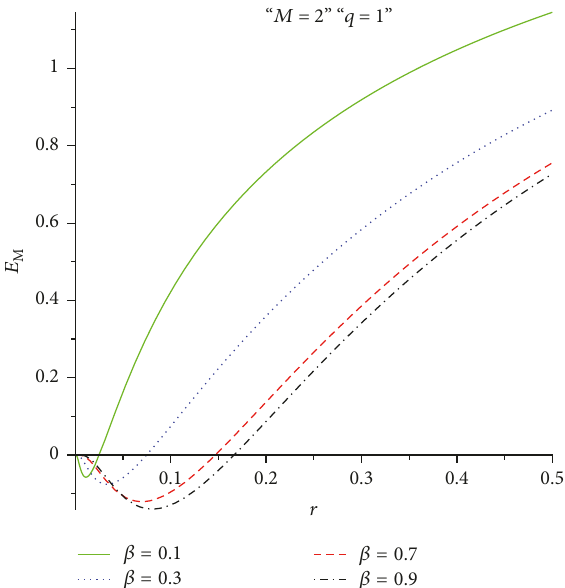
Figure 4: Energy distribution near zero obtained in the Møller prescription for different values of 𝛽